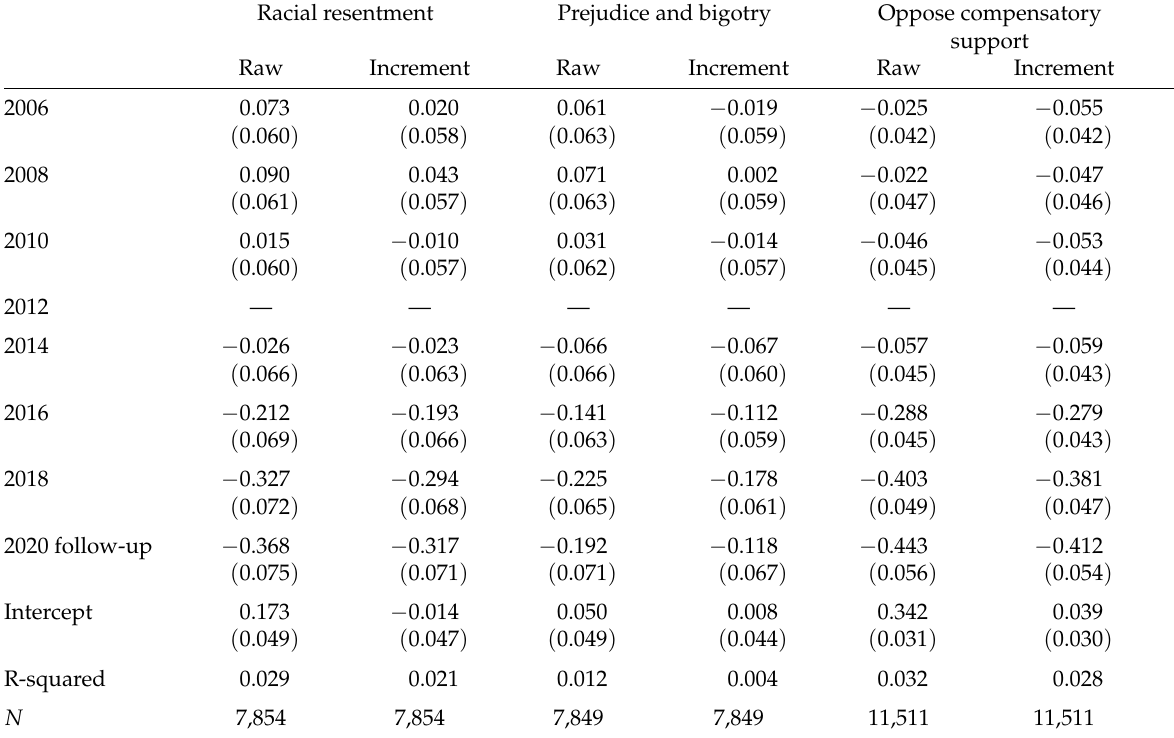
Table 4: Least squares models for period effects on scales of racial resentment, prejudice and bigotry, and opposition to compensatory support for white-only, non-Hispanic respondents, 2006 to 2020 Racial resentment Prejudice and bigotry Oppose